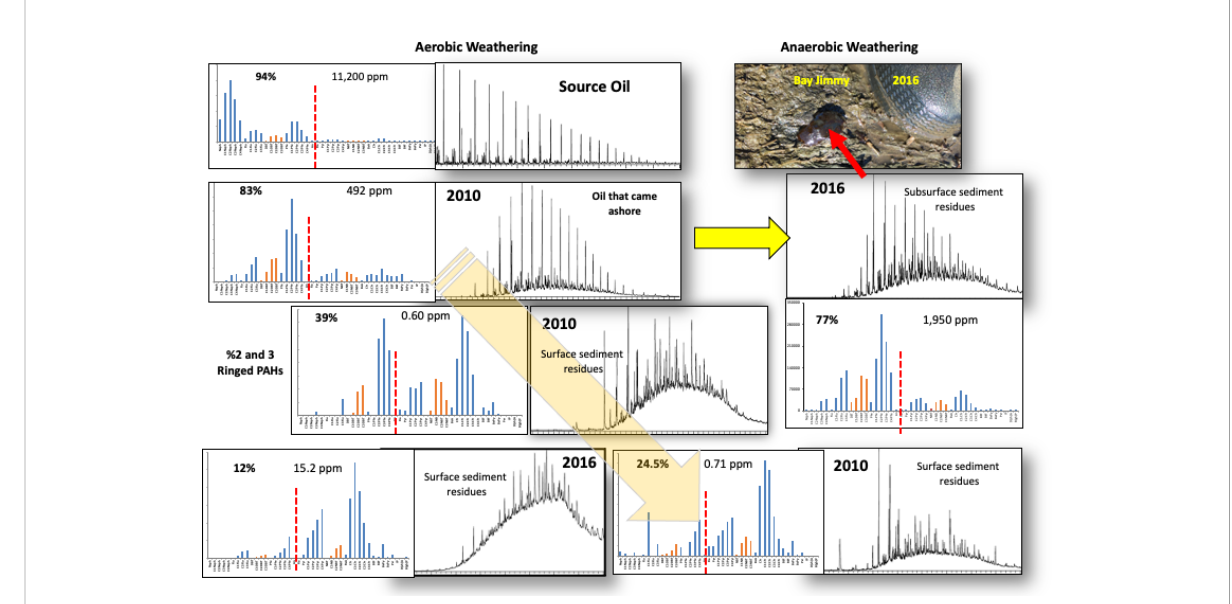
FIGURE 14 Overview of the alkane and PAH compositional trends for weathering of Macondo oil once stranded on Louisiana coastal marshes through the summer of 2010 and extended to 2016. Oil stranded in 2010 was weathered rapidly in aerobic environments with daily tidal surface washing with oxygenated seawater. A portion of the stranded oil was buried below vegetated surface tarmats and in fi ddler crab burrows in anaerobic conditions, and this oil weathered much more slowing with compositional pro fi les in 2016 similar to recently stranded 2010 oil